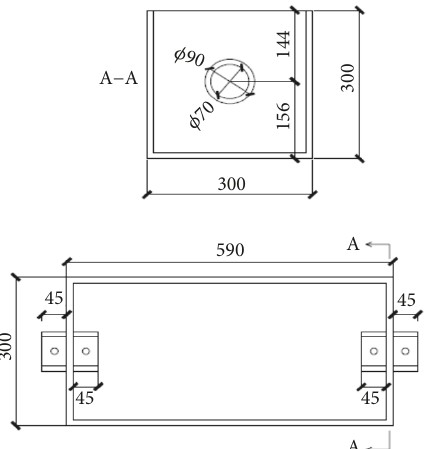
Figure 6: Diagram showing measurement of immersion tank.